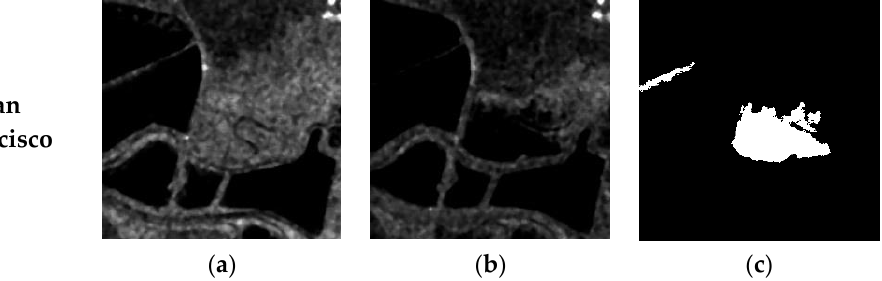
Figure 7. Yellow River dataset. ( a ) Image acquired in June 2008; ( b ) image acquired in June 2009; ( c ) ground truth.